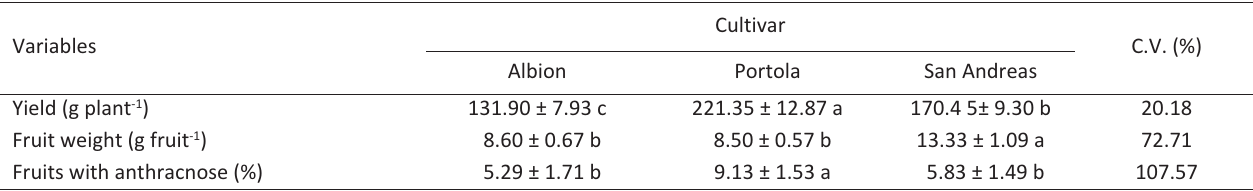
(z) Means followed by different lowercase letters in the row, differ by Tukey test at 5% error probability. The averages correspond to the isolated effect of cultivar factor to